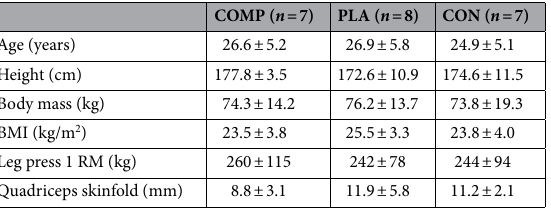
Table 7. Descriptive characteristics of participants in experimental groups (mean ± SD).